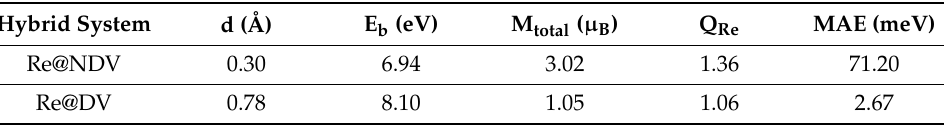
Table 1. The distance (d) between the Re atom and graphene, binding energy (E b ), the total magnetic moment (M total ) the charge (Q) of Re atoms, and magnetic anisotropy energy (MAE) for Re@NDV and Re@DV. (Re@DV means double-divacancies graphene adsorbs Re atoms; Re@NDV means nitrogenized-divacancies graphene adsorbs Re atoms.) Hybrid